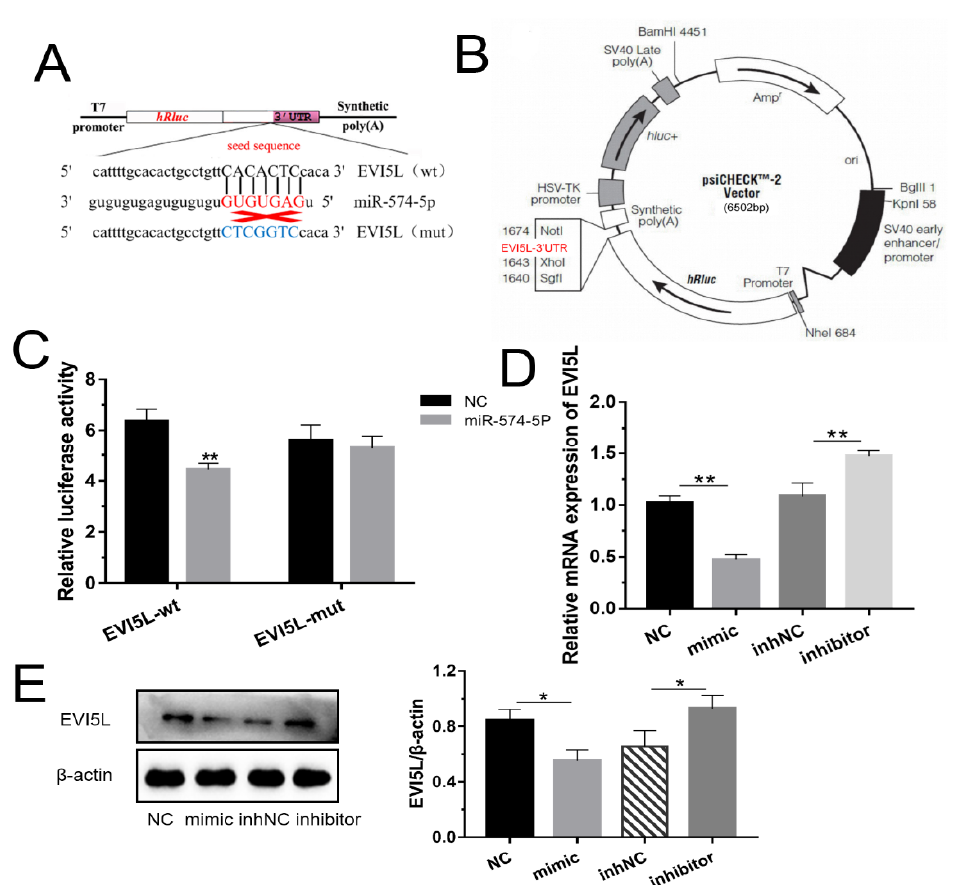
Figure 1. MiR-574-5p-targeted and down-regulated EVI5L. ( A ) EVI5L presents a complementary sequence (GCS), 3′ untranslated region (3′ UTR), binding the seed sequence of miR-574-5p. ( B , C ) Contribution vector to test the luciferase expression and the result of the luciferase assay. ( D ) The analysis result about the mRNA expression of EVI5L by RT-qPCR. ( E ) Western blot analysis of EVI5L expression after 48 h transfection with miR-574-5p mimics, inhibitors, NC and inhNC in goat mammary epithelial cells (GMECs). WT- EVI5L -WT, WT- EVI5L -psiCHECK2; EVI5L -mut, MUT- EVI5L -psiCHECK2; NC: negative control; inhNC: inhibitor negative control. ** means significant difference ( p < 0.01), * means significant difference ( p < 0.05).